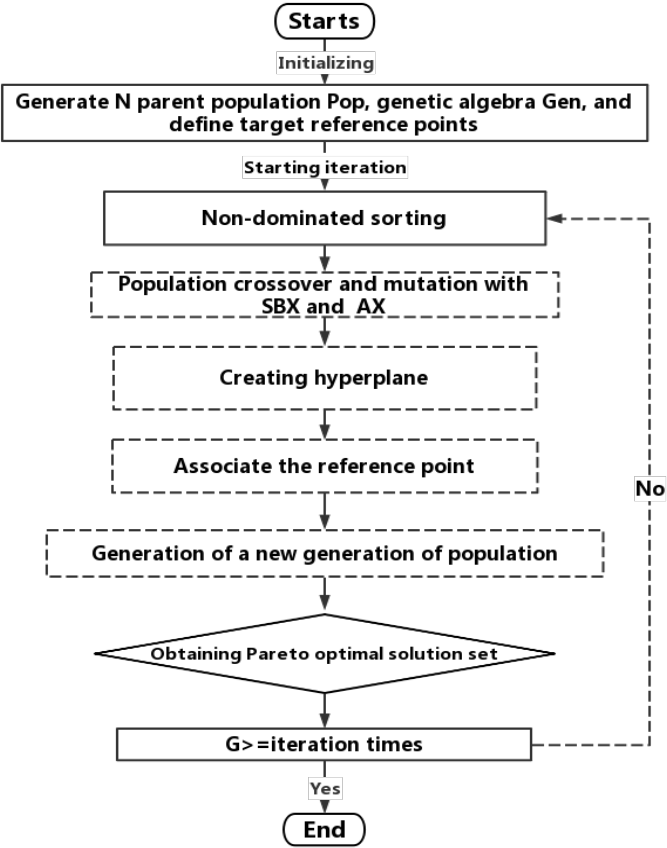
Figure 3. Schematic flow diagram of the improved NSGA-III.